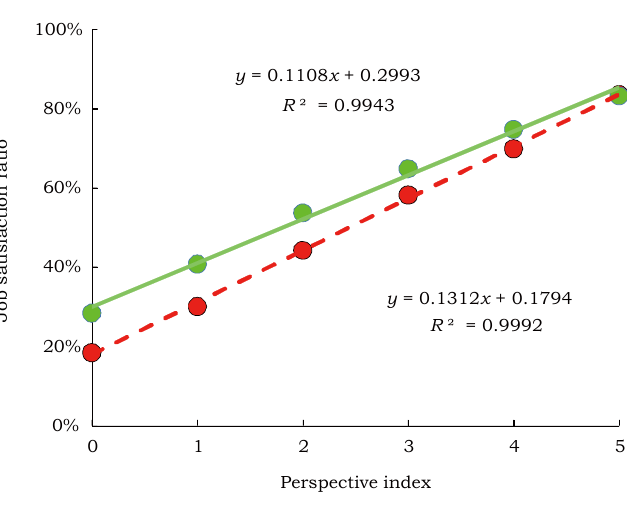
Figure 3. Perspective index and job satisfaction ratio Note: The bold green line shows the Survey X data (2004–2013), N = 13,034; the dashed red line shows the JPC Survey data (1992–2000), N =